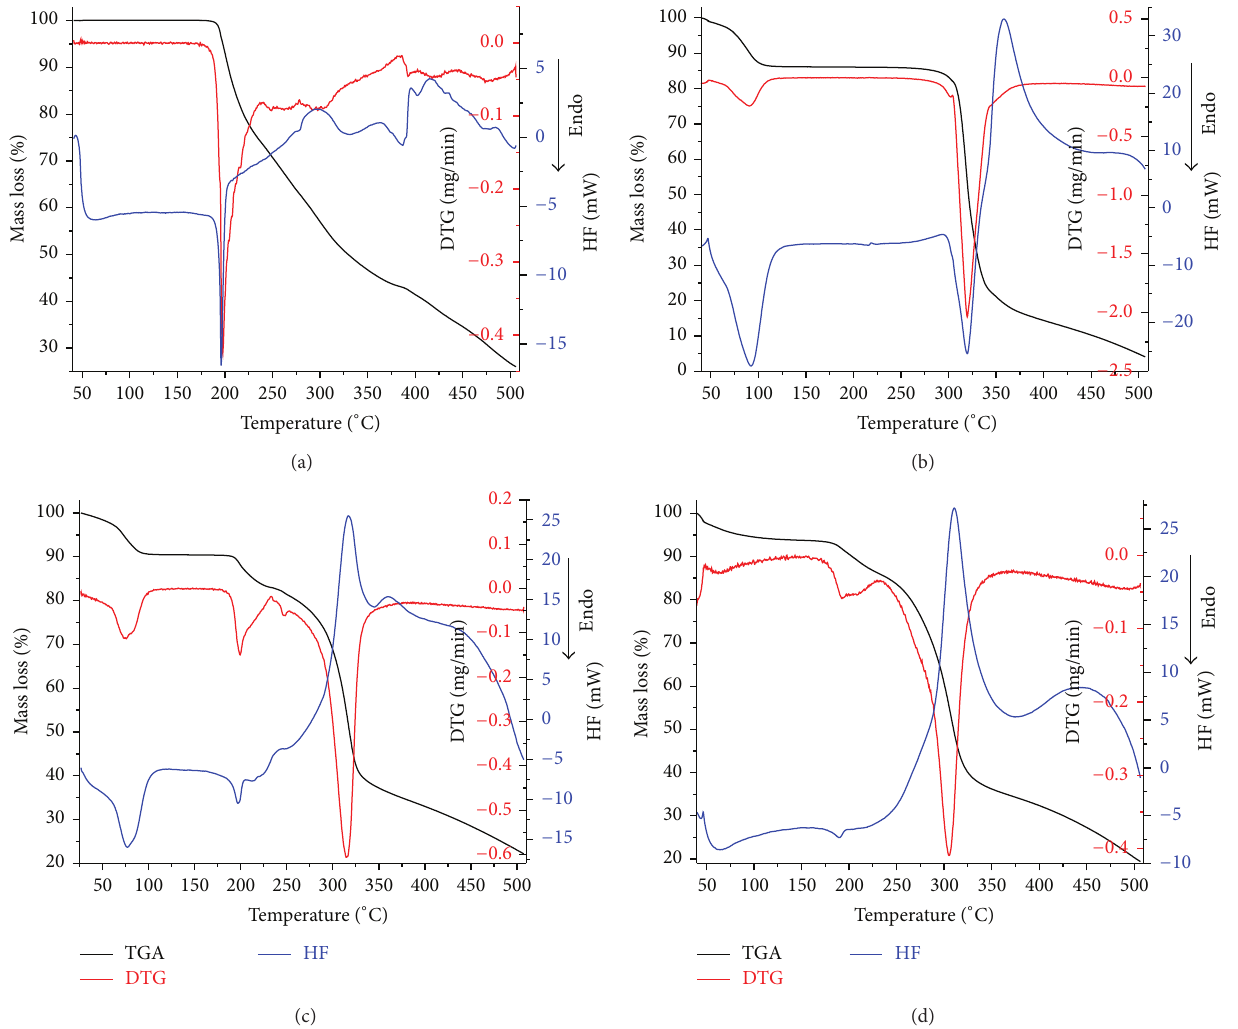
Figure 5: The thermal profile of (a) FOS, (b) 𝛽 -CD, (c) FOS/ 𝛽 -CD physical mixture, and (d) FOS/ 𝛽 -CD kneaded product.